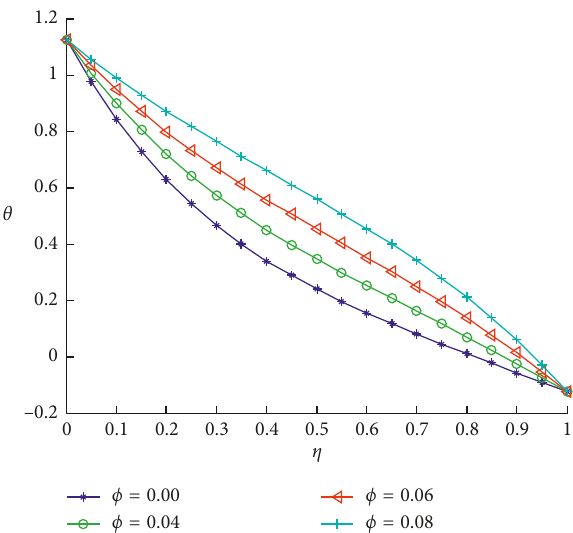
Nb 0 . 2 , β 0 . 05 , M (cid:31) (cid:31) (cid:31)